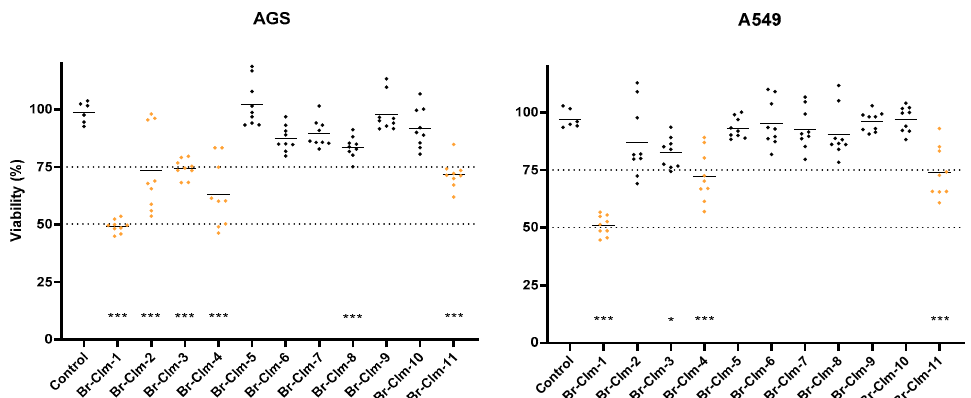
Figure 8. Effect of Br-Clm (renamed Br-Clm-1 ) analogs upon the viability of AGS ( left ) and A549 ( right ) cells at 24 h. All compounds were tested at 100 µ M, and viability was assessed using the MTT method. Each dot represents an individual determination. Statistical analysis was conducted between each treatment and the control. * p < 0.05, *** p < 0.001.